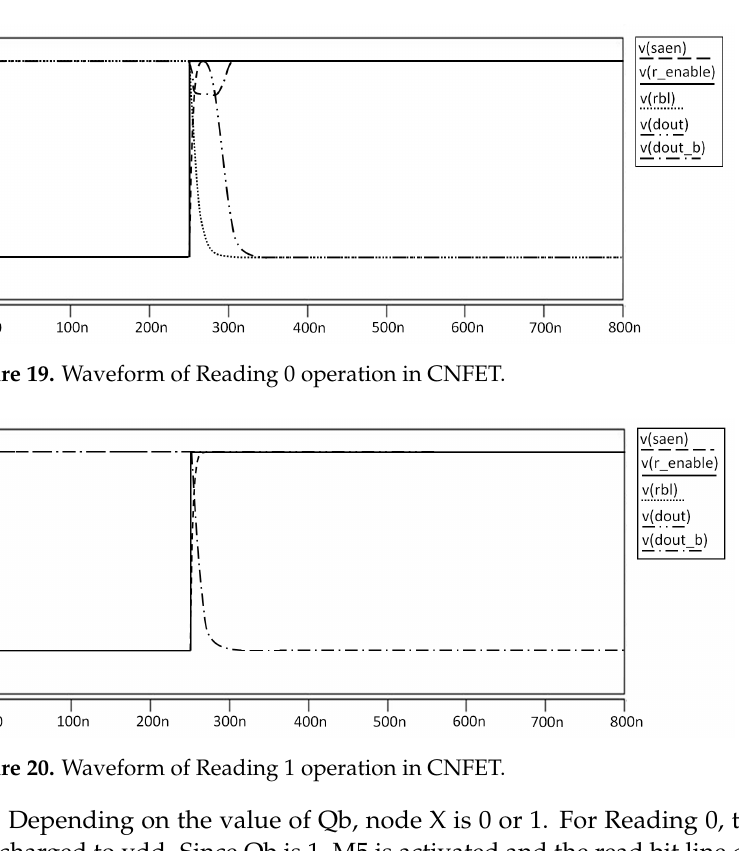
Figure 18. Waveform of Reading 1 operation in FinFET.